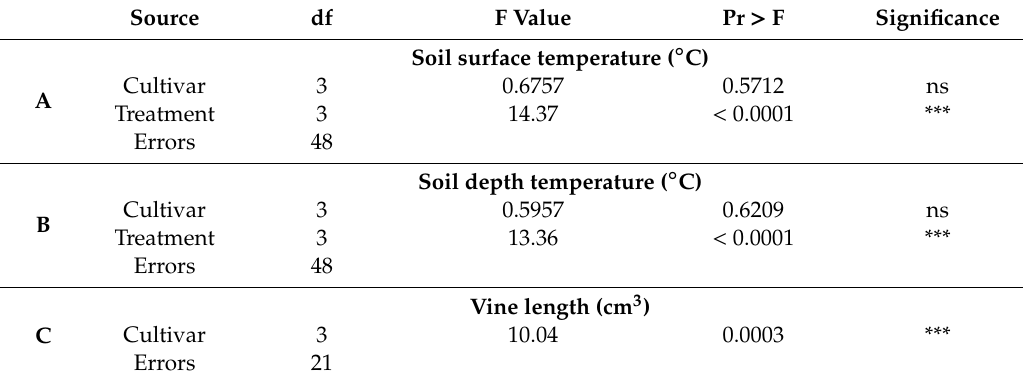
Table 2. ANOVA results for soil temperatures (surface and depth), soil moisture content, and vine length of sweetpotato roots.